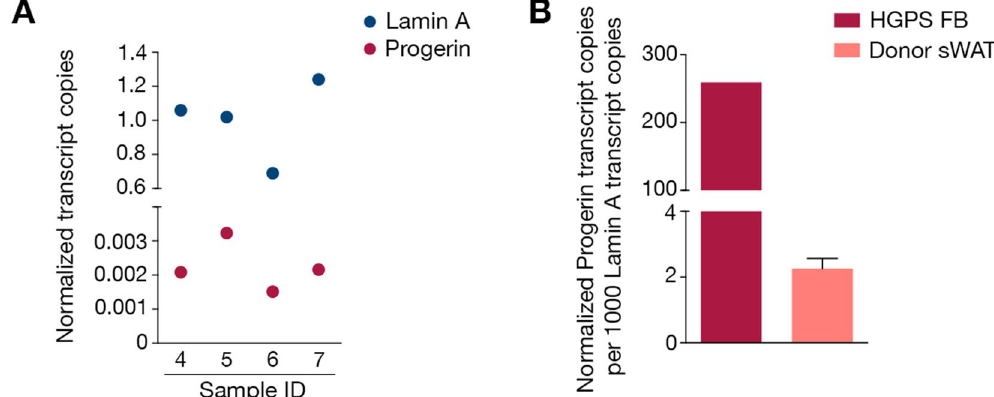
Figure 1. Progerin characterization in human sWAT. ( A ) Graph showing the normalized copy number of progerin and lamin A in healthy human sWAT. ( B ) Graph representing the ratios of progerin to lamin A after normalization to GAPDH as obtained by ddPCR analysis, in HGPS patient fibroblasts (FB) and healthy human sWAT. Data are represented as mean ±